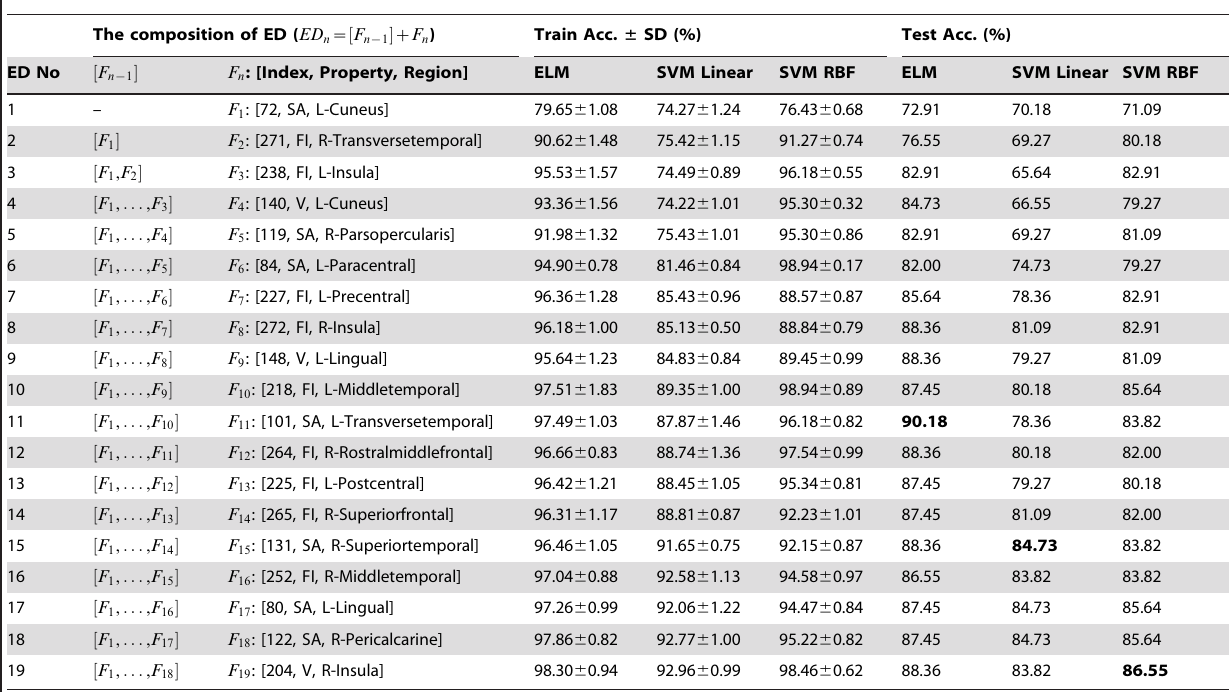
Table 3. Comparison of the training and testing accuracy of ELM and SVM in ADHD classification.